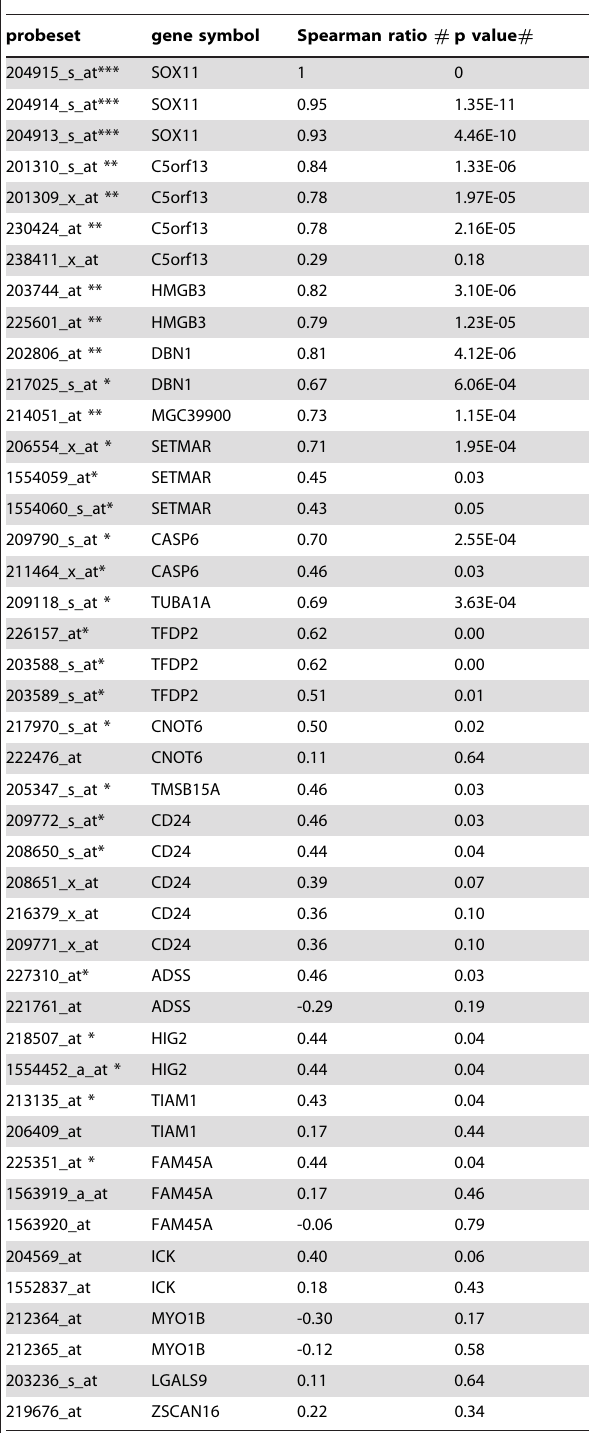
Table 3. Validation of SOX11 siRNA downregulated genes in a series of SOX11 + and SOX11- MCL a) .